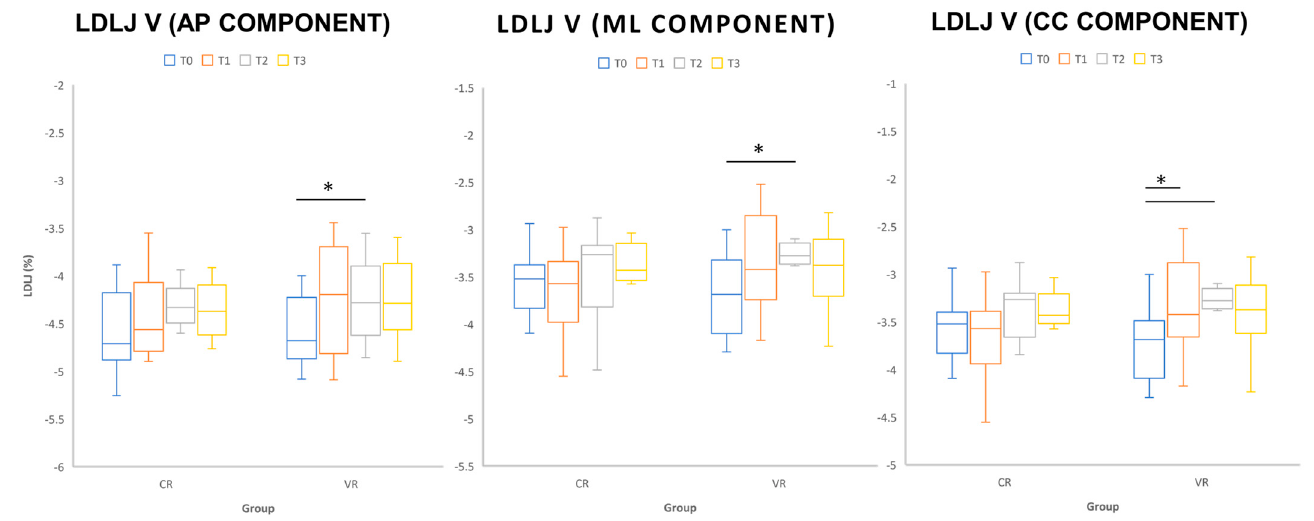
Figure 2. Whiskers’ plots of LDLJv smoothness parameter in the AP, ML, and CC components as obtained during figure 8 walk test in the different T0, T1, T2, and T3 sessions. Horizontal lines and asterisks indicate significant statistical differences ( p < 0.05). Table 3. F8WT parameters divided into three subdomains of interest (i.e., spatio-temporal, stability, smoothness). Mean ± standard deviation values are reported for both VR and CR in the four assessment sessions. The presence of main effects of the session is highlighted, indicating the two sessions where statistical significance was found (e.g., “03” stands for a difference between T0 and T3).